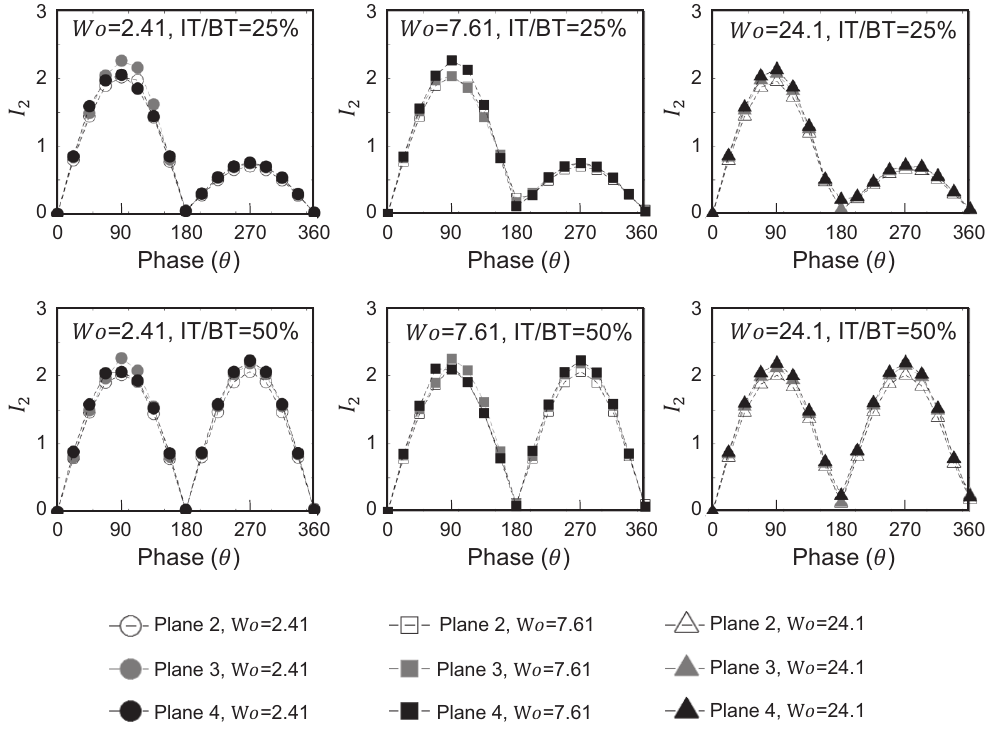
Figure 14. Integral parameter I 2 calculated at Planes 2–4 for all breathing conditions at IT/BT = 25% ( top row ) and IT/BT = 50% ( bottom row ). Refer to Figure 12 for marker